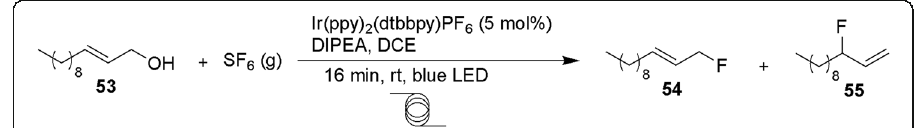
Fig. 15 Deoxyfluorination using SF 6 under continuous flow and photochemical conditions